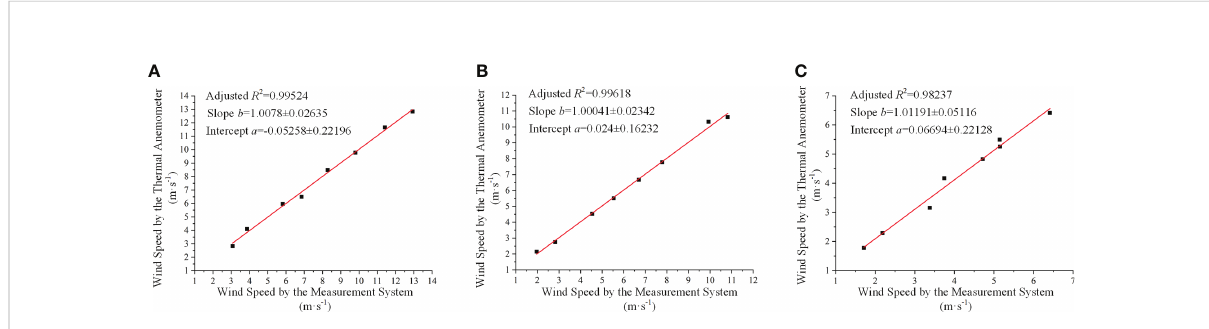
FIGURE 11 The regression between the anemometer and the calibrated measurement results, where (A – C) correspond to Carbon Fibre Tube 1, Carbon Fibre Tube 2 and Carbon Fibre Tube 3,